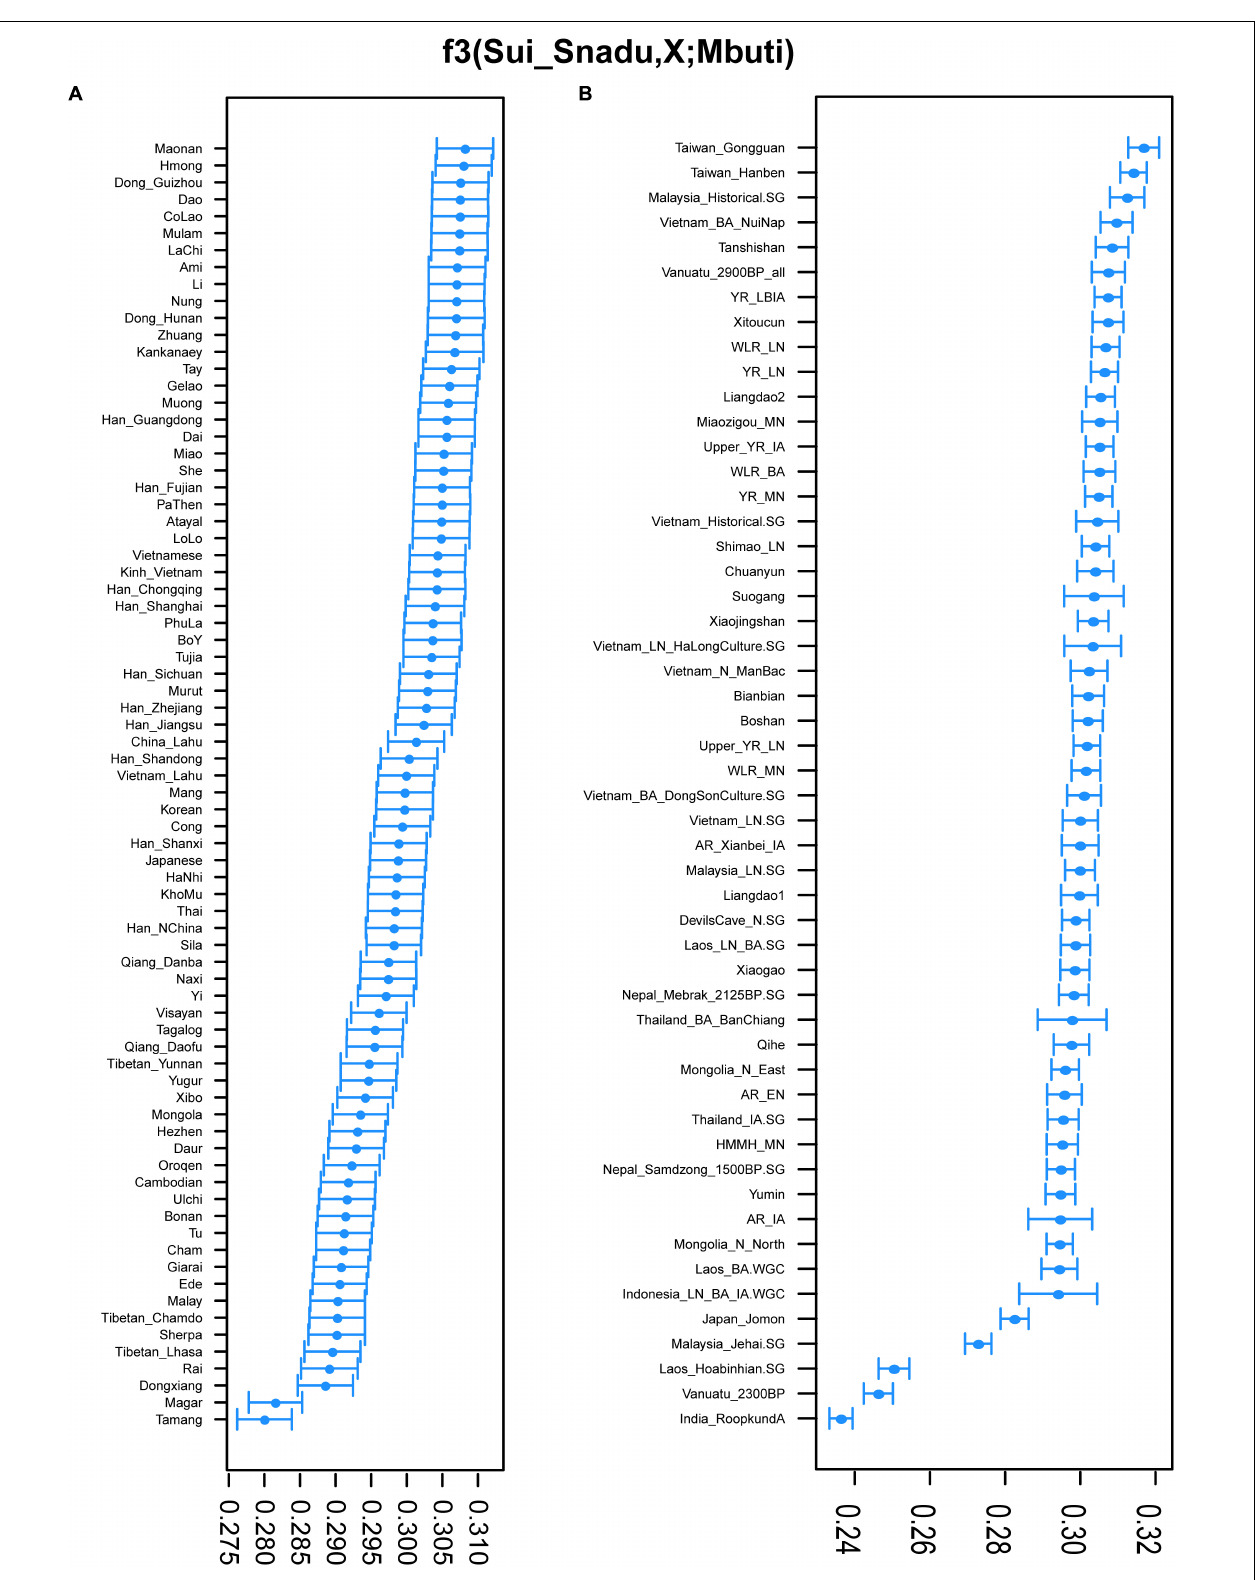
Frontiers in Ecology and Evolution |